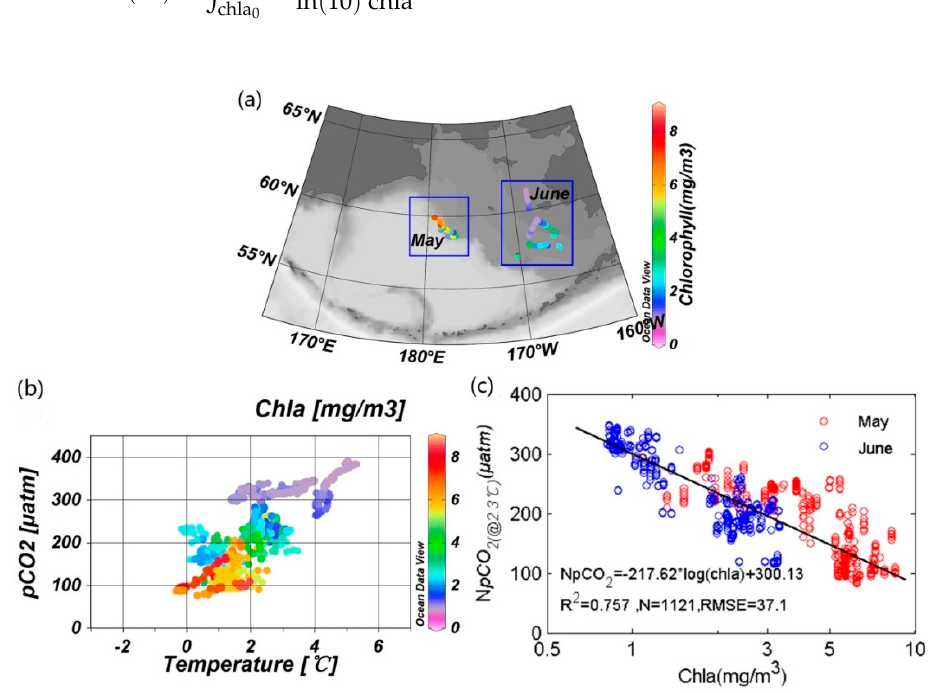
Figure 4. Biological effect on p CO 2 . ( a ) The location of match-up data between eight-day composite satellite chla and the underway data in May and June in 2010; ( b ) the relationship between p CO 2 and temperature; ( c ) the relationship between p CO 2 normalized to the average temperature of 2.3 °C (N p CO 2 ) and chla .